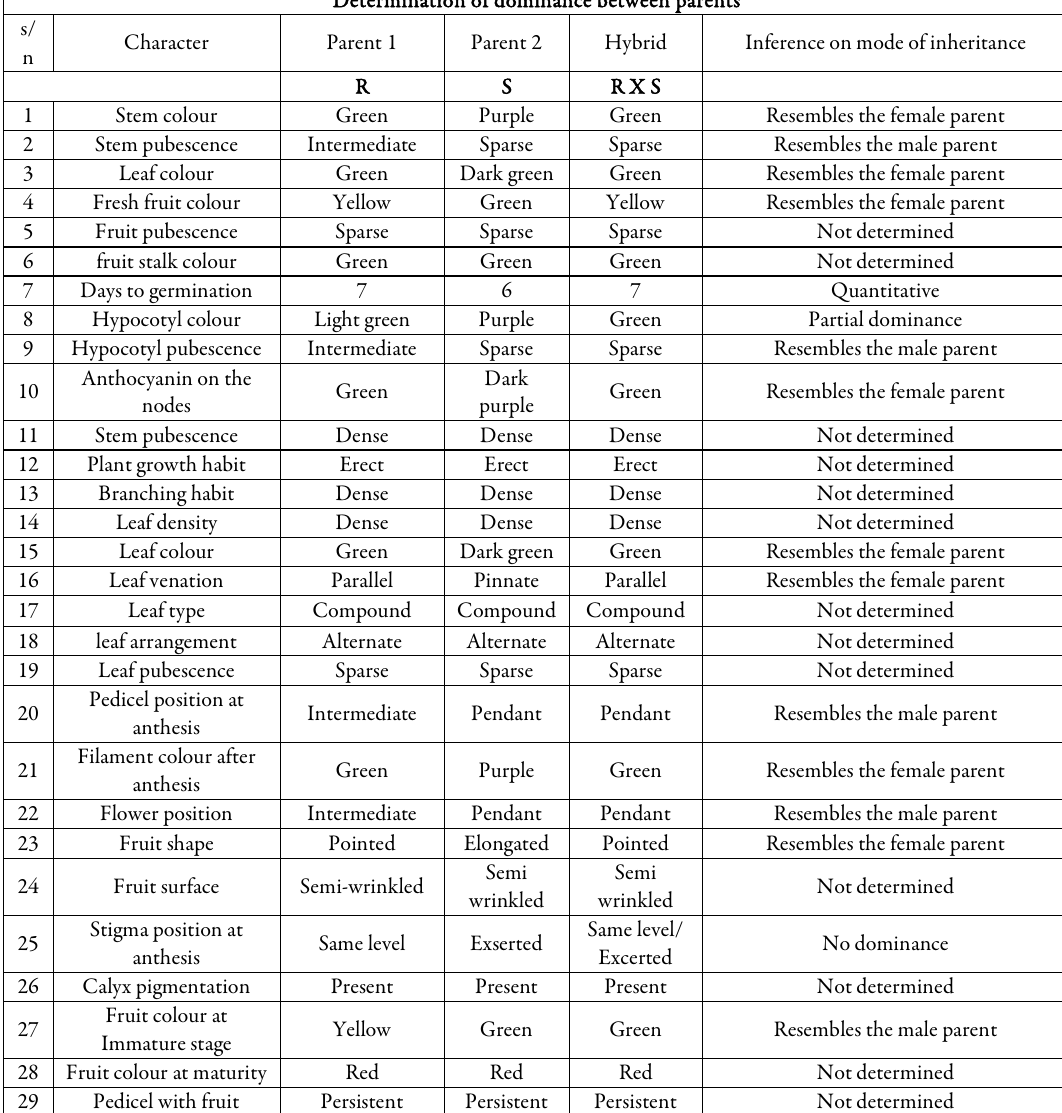
Table 9. Comparison of R and